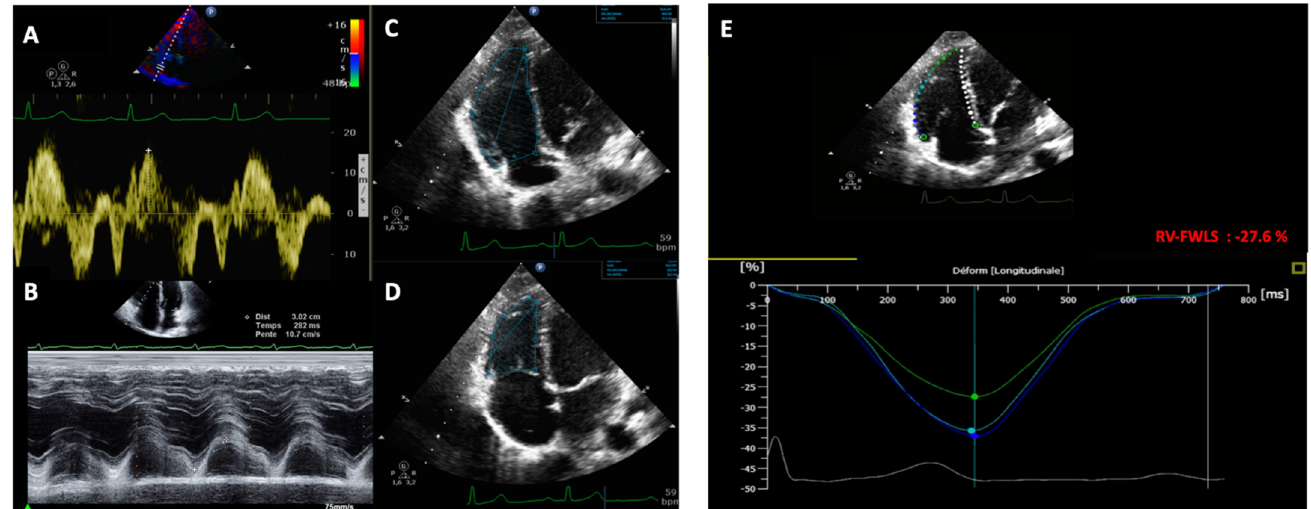
Figure 1 . Measurement of the RV conventional parameters and the RV-FWLS in a RV-focused ap- ical four-chamber view. ( A ) RV-S’ wave measured in tissular Doppler imaging. ( B ) TAPSE measure in M-mode. ( C , D ) End-diastolic RV area and end-systolic RV area measured for RV-FAC. ( E ) Automatic RV-FWLS measured by the QLAB AutoStrain Software.